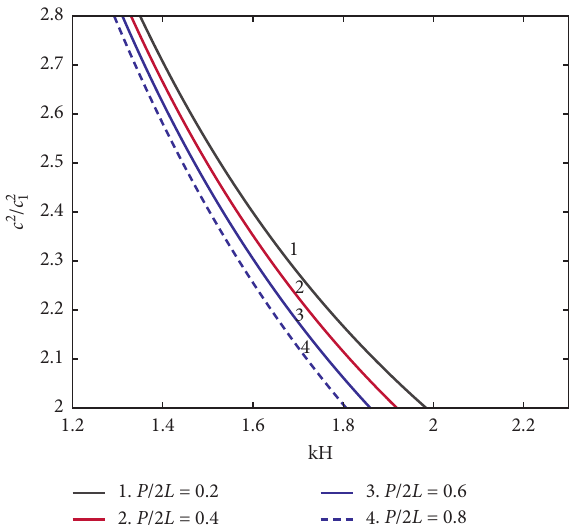
Figure 2: Model-II: medium of the propagation under soft mountain surface.